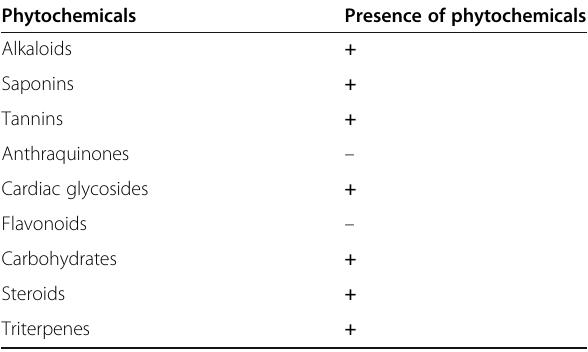
Table 1 Phytochemical screening of aqueous stem bark extract of P.